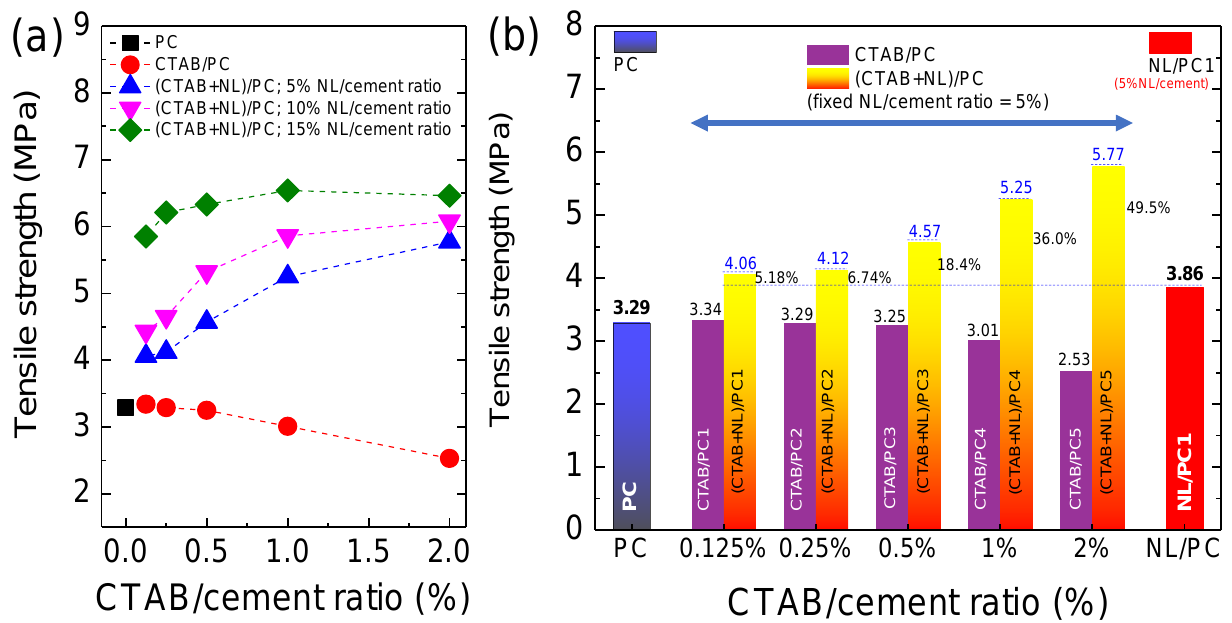
Figure 8. ( a ) CTAB/cement ratio dependence of the tensile strength for the CTAB/PC and (CTAB + NL)/PC composites with NL/cement ratio = 5%, 10%, and 15% compared to that of the control PC. ( b ) Tensile strength of the CTAB/PC and (CTAB + NL)/PC (fixed NL/cement ratio = 5%) composites with different CTAB/cement ratios (0.125 – 2%) compared to those of the control PC and NL/PC1 composite.